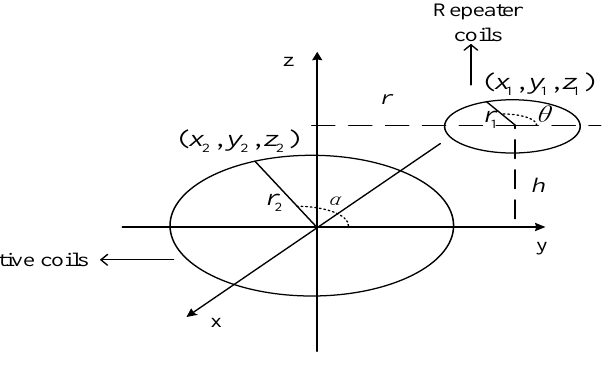
Figure 1. Proposed system for UAV charging.